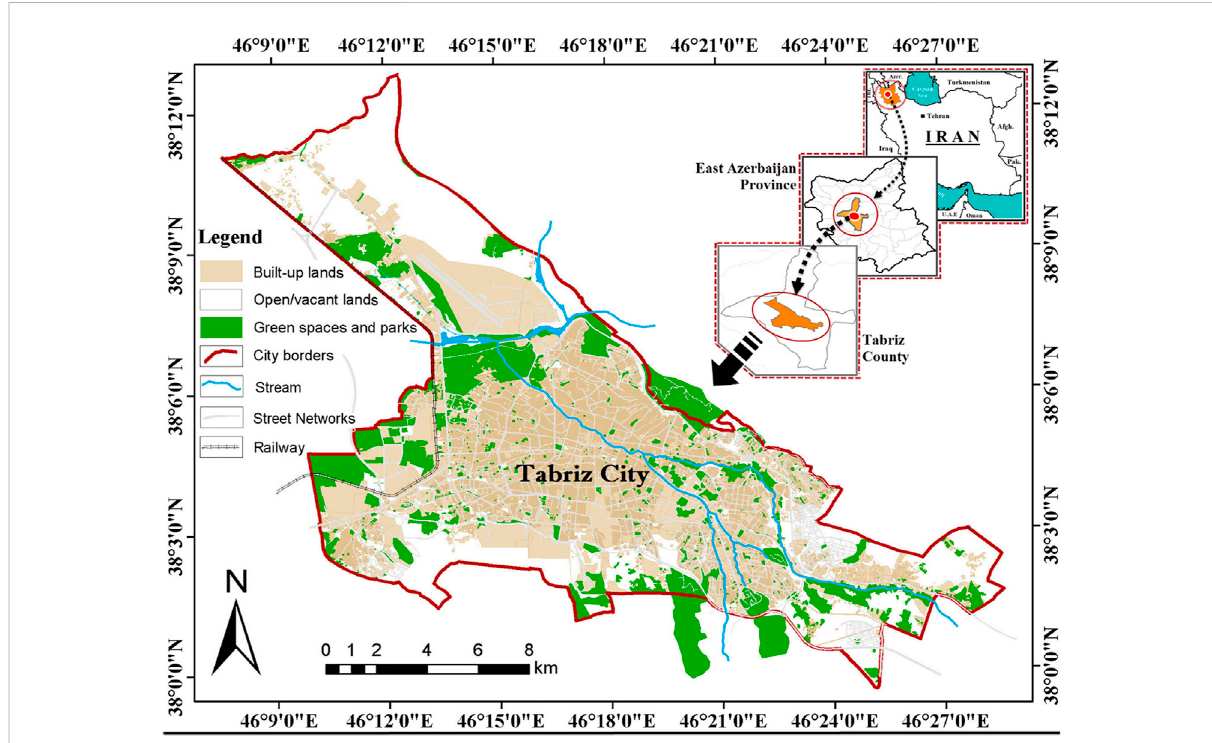
FIGURE 1 Location of the study area in the metropolitan region of Tabriz, NW Iran, and its land use